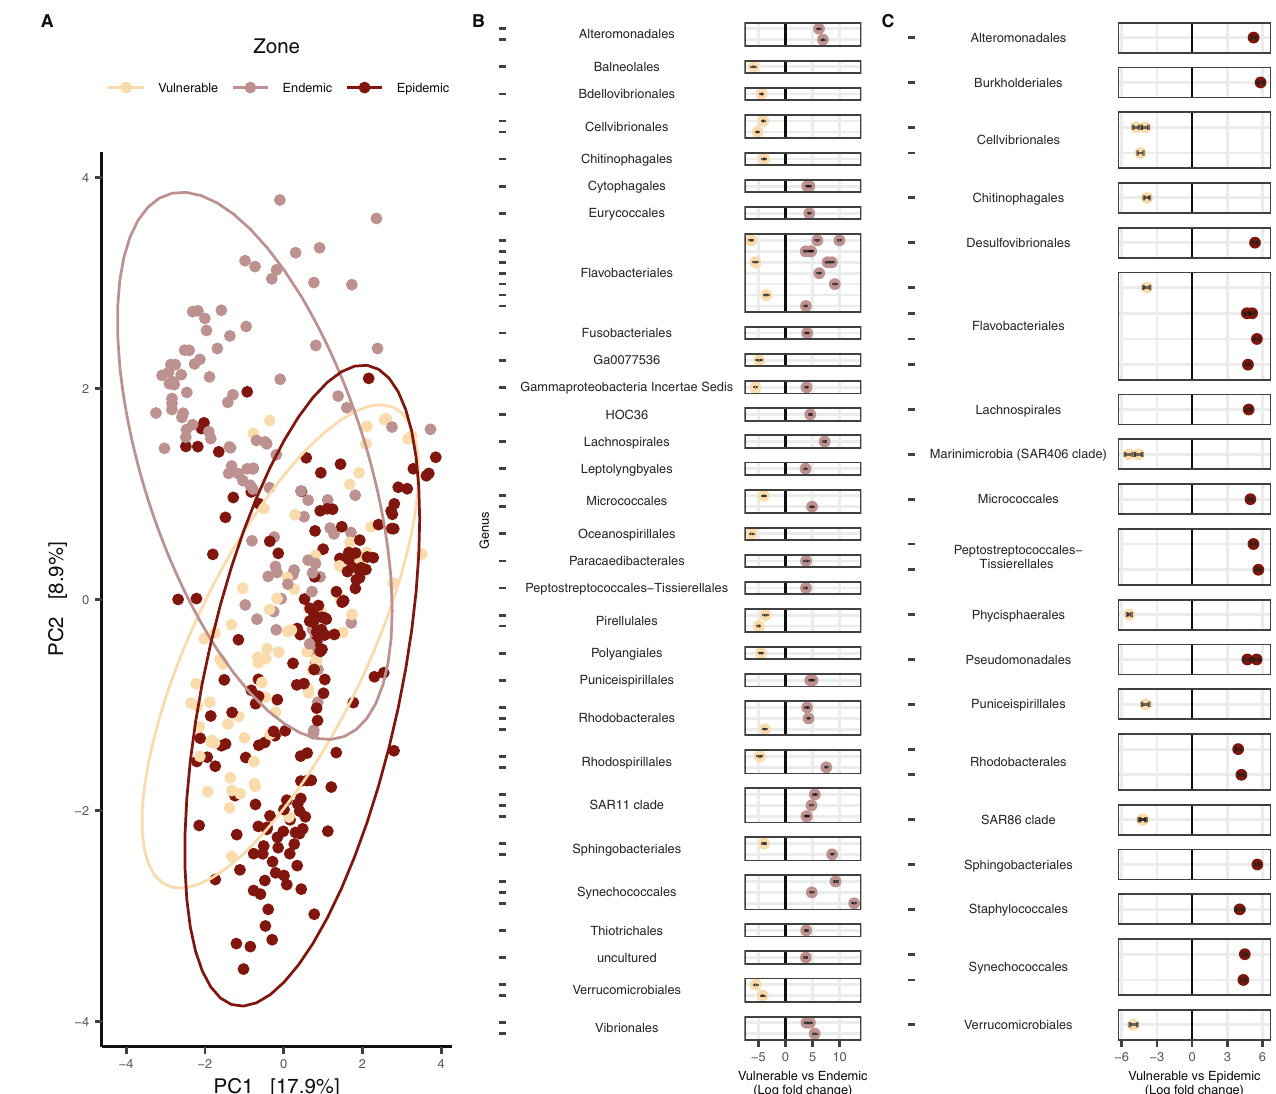
Fig. 2 Comparisons among microbial communities of fi eld-sourced apparently healthy (AH) coral colonies across stony coral tissue loss disease (SCTLD) zones (vulnerable, endemic, and epidemic). A beta-diversity (centered log-ratio transformed and plotted with a Euclidean distance), and differential abundance analysis in ( B ) vulnerable vs endemic zones, and C vulnerable vs epidemic zones. ASVs are grouped by genus (represented by dashes) on the y axis and then by order, and only ASVs with a P adj < 0.001, a W statistic >90, and a log-fold change < − 2 and >2 were visualized. AH samples from the three coral compartments (mucus, tissue slurry, and tissue slurry skeleton) were included and Acropora spp. samples were excluded from the analysis. The ellipses in ( A ) represent the center of the Euclidean distance from the respective zone with a 95% con fi dence of the DU tissue slurry samples were most enriched in Synechococcales ( Synechococcus CC9902; log-fold = 20.04) and Flavobacteriales (NS5 marine group; log-fold = 12.71), with Flavobacteriales having the most enriched ASVs ( n = 9). Tissue slurry skeleton sample comparisons of AH vs DU identi fi ed no ASVs enriched in DU. In addition to coral compartment samples, ASVs enriched in AH and DU samples were also present within sediment and seawater samples. The enriched taxa were also detected across the three zones with Flavobacteriales and Synechococcales found at higher relative abundances in sediment and seawater of endemic and epidemic zones compared to the vulnerable zone (Supplementary Fig. 5). However, some taxa such as Burkholderiales and Staphylococcales were also present at high relative abundances in lab control samples compared to other taxa and thus could be artifacts of contamination (Fig. 5B) [37].